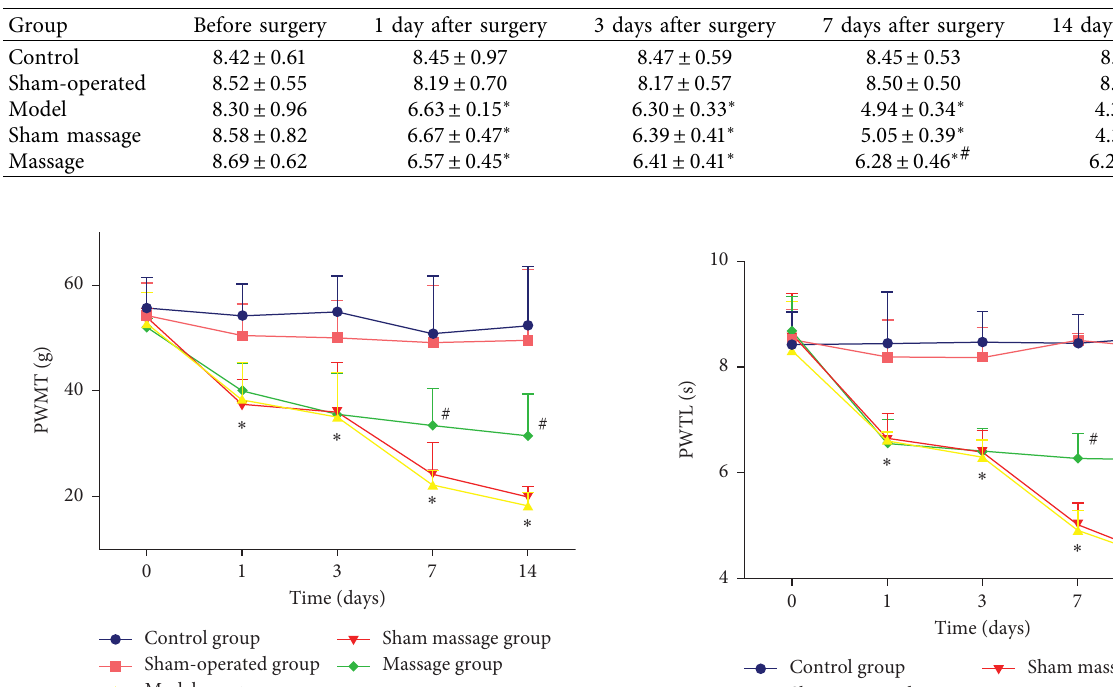
Table 3: PWTLs of the rats. The data are shown as X ± s (g, n � 8). ∗ P < 0 . 05 compared with the control group; # P < 0 . 05 compared with the model group.